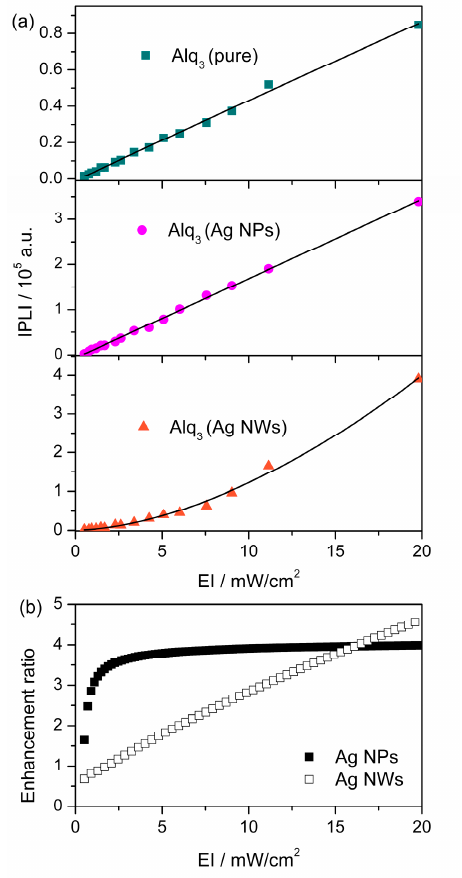
Figure 7. ( a ) EI-dependent IPLI of Alq 3 (pure), Alq 3 (Ag NPs) and Alq 3 (Ag NWs); ( b ) IPLI enhancement ratio as a function of EI.